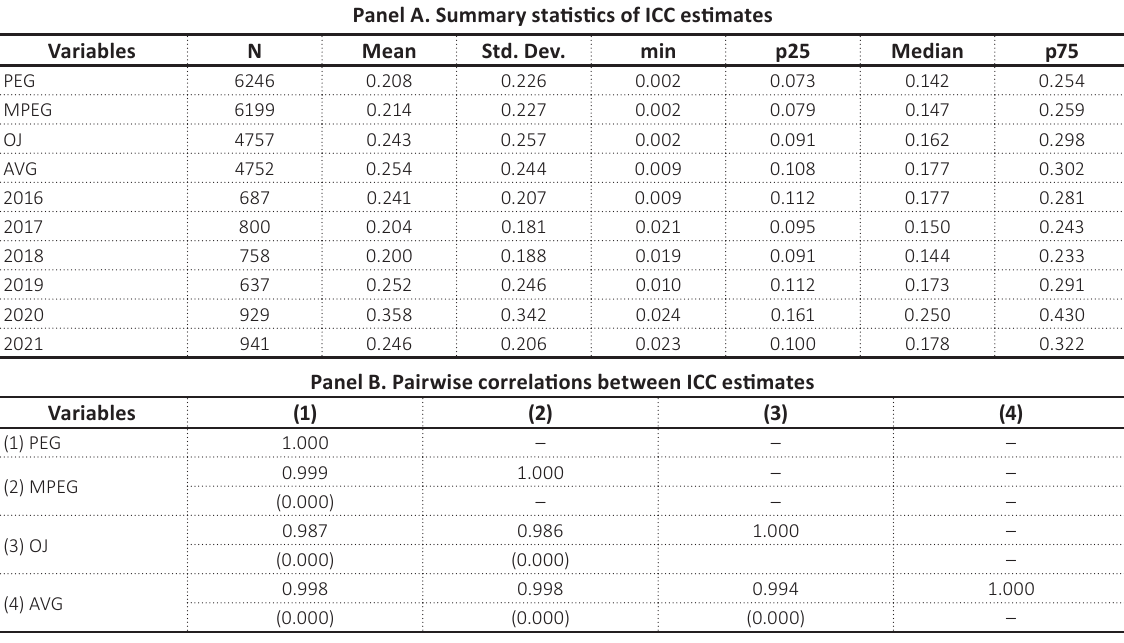
Table B1. Summary statistics of ICC estimates Panel A. Summary statistics of ICC estimates